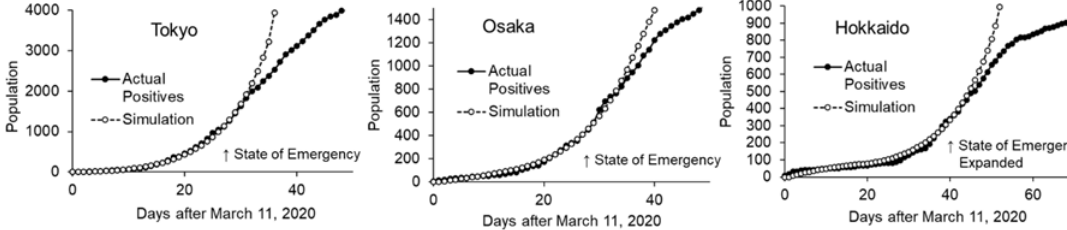
Figure 4. Simulation without intervention and actual patient numbers in 3 regions.